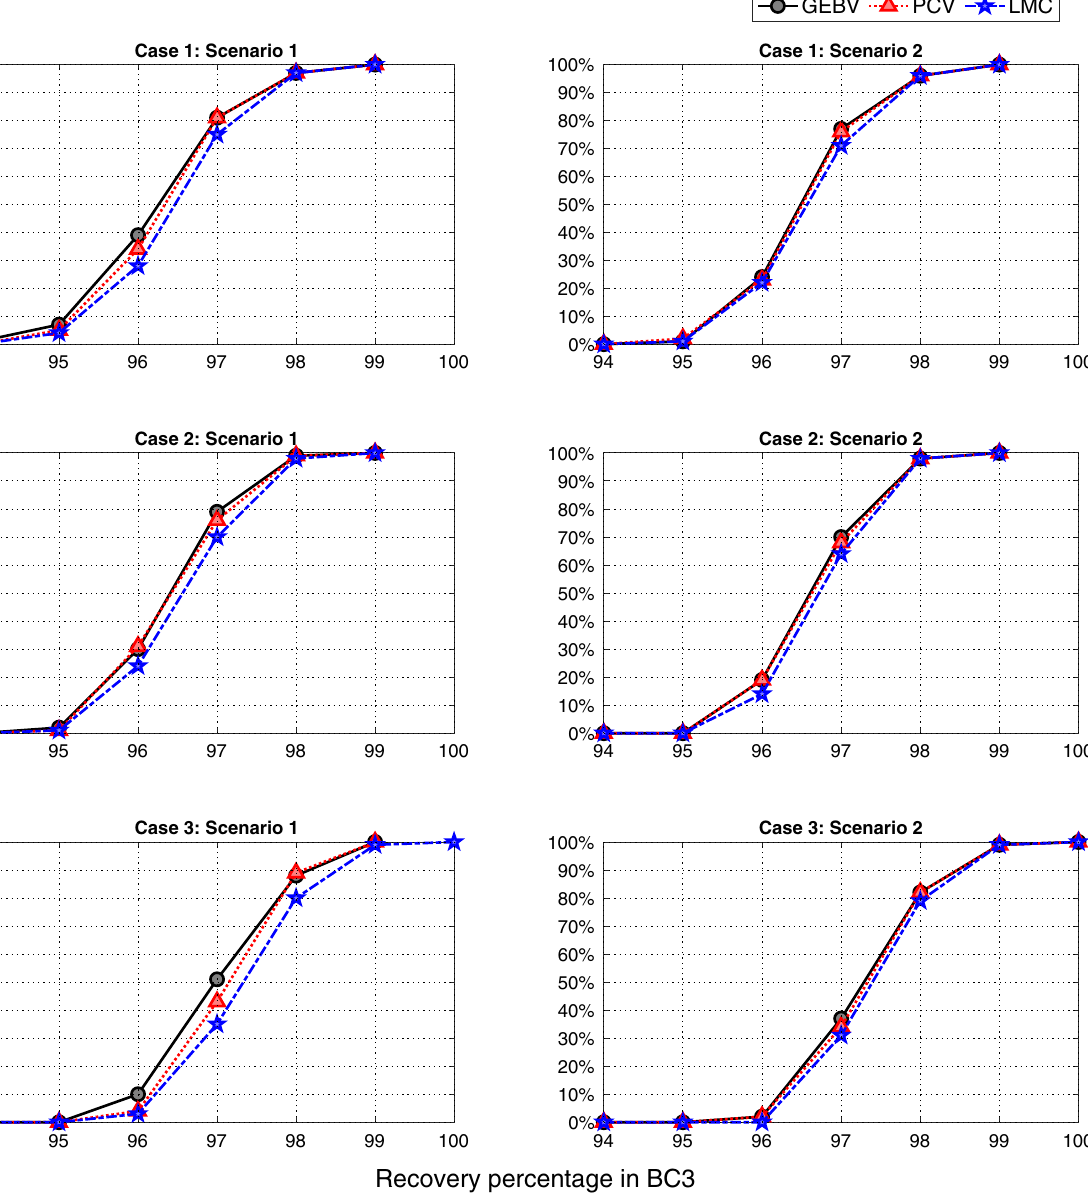
Figure 5. Cumulative distribution functions of population maximum in the BC3 for three cases and two different scenarios. Results are based on 100 simulation